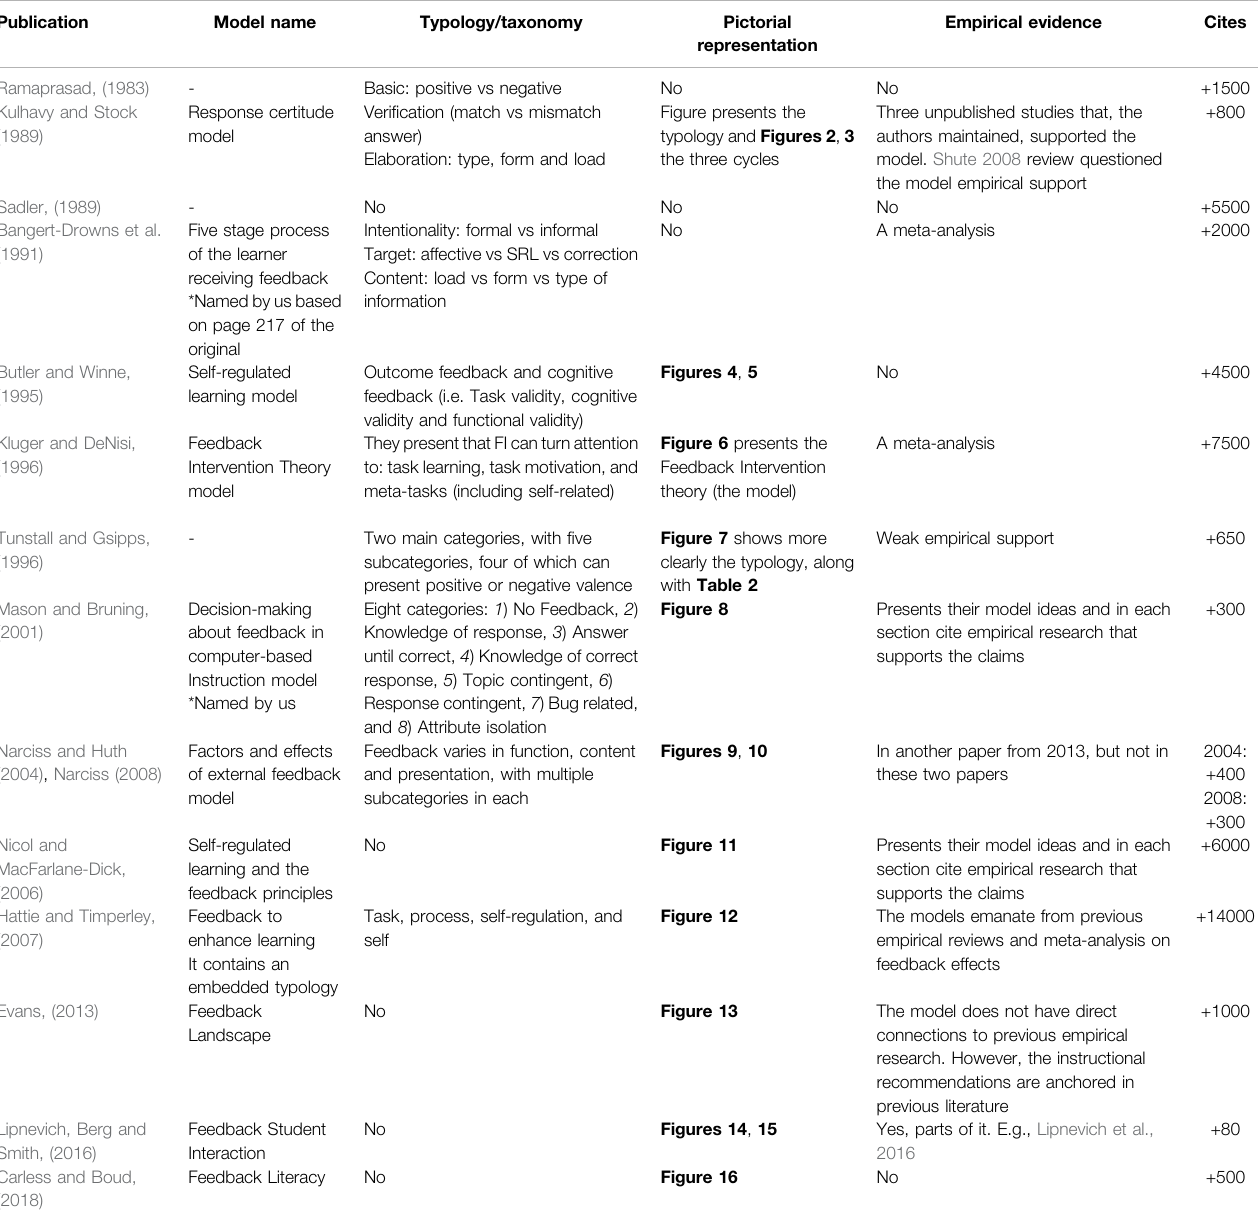
The models emanate from previous empirical reviews and meta-analysis